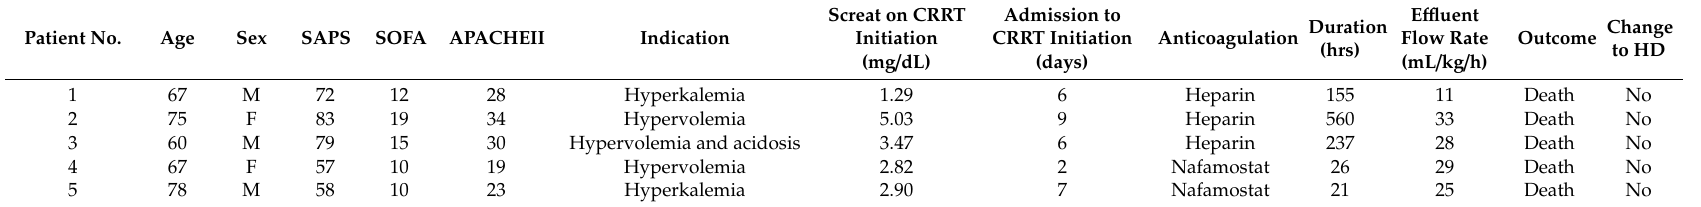
Table 7. Information regarding patients who underwent continuous renal replacement